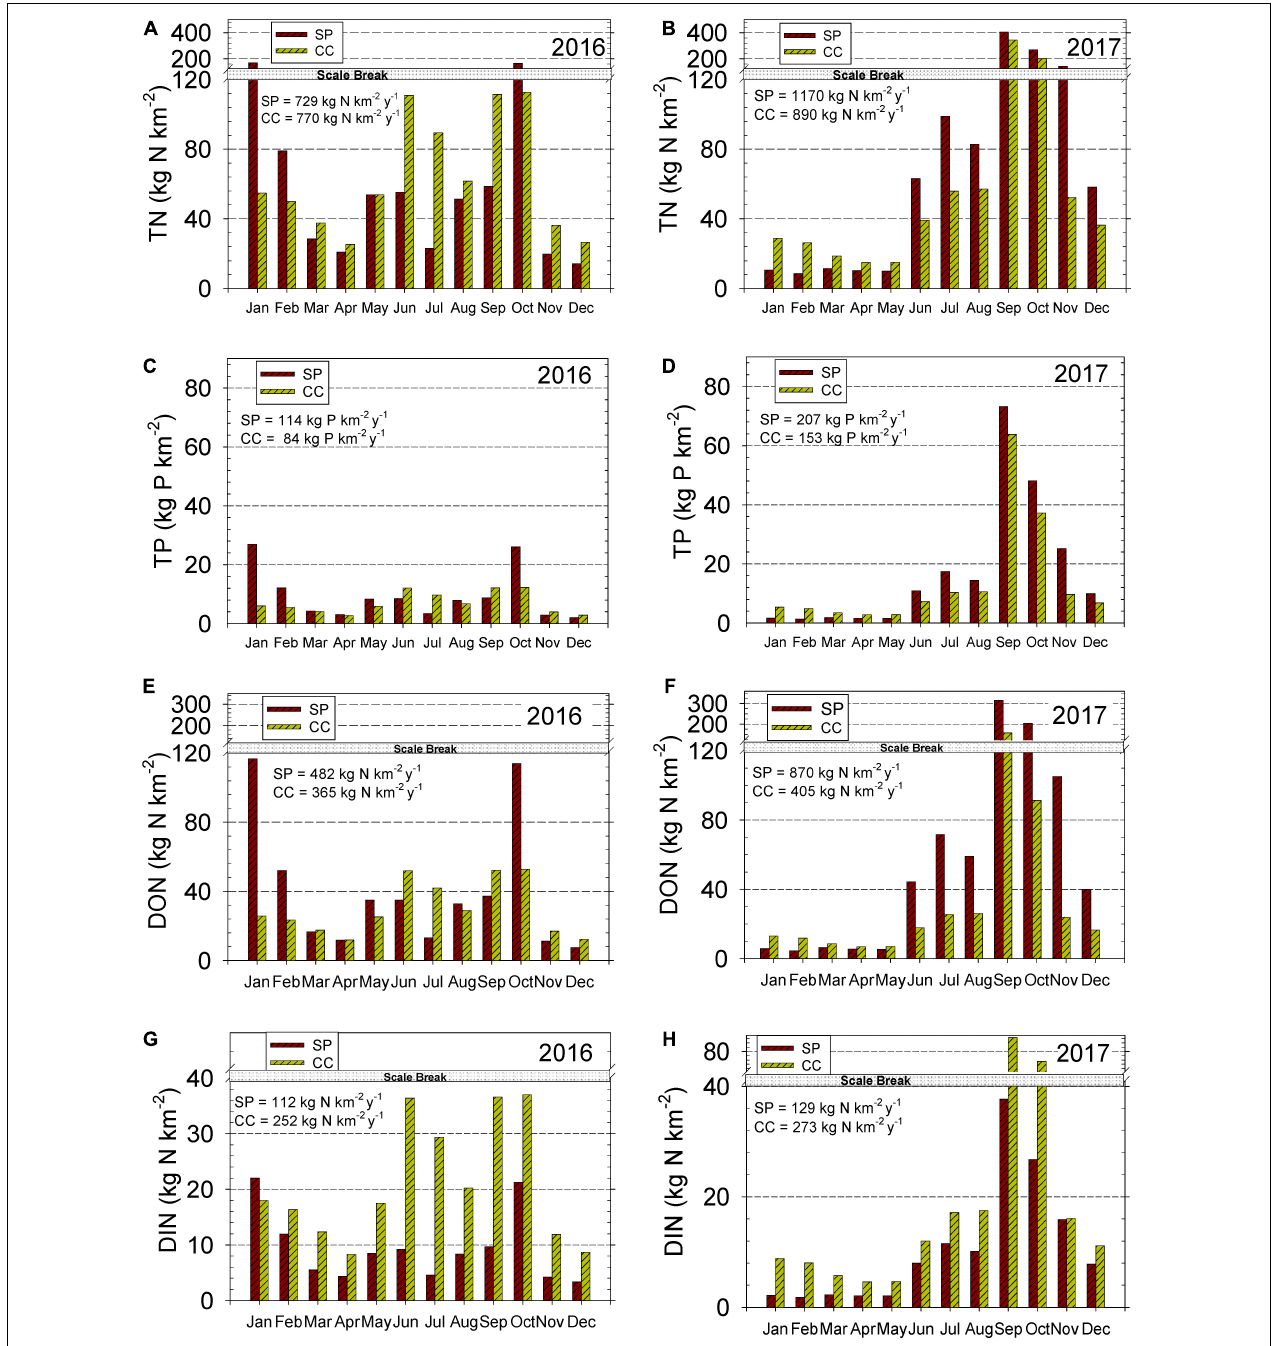
FIGURE 5 | Yields from South Prong Saint Sebastian River (SP) and Crane Creek (CC) to the Indian River Lagoon (IRL) during 2016 and 2017 for (A,B) total nitrogen (TN), (C,D) total phosphorus (TP), (E,F) dissolved organic N (DON), and (G,H) dissolved inorganic N (DIN). Totals for each year shown on upper left of graphs.